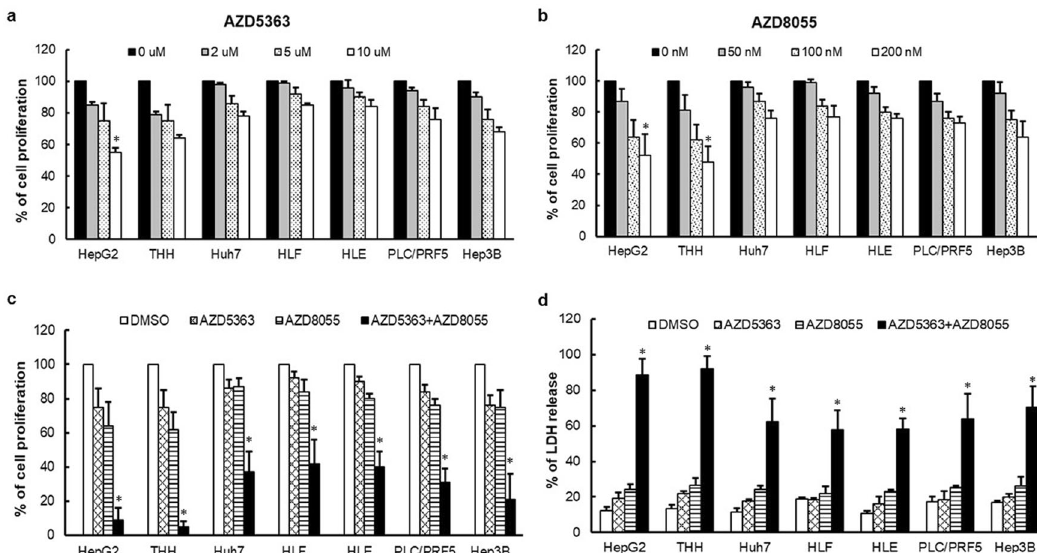
Fig. 1 Inhibition of cell proliferation by speci fi c inhibitors. Proliferation of different HCC cells were analyzed separately by MTS assay after treatment with AZD5363 ( a ) and AZD8055 ( b ), at different concentrations for 72 h. Proliferation was also analyzed by MTS assay after a combination treatment with 5 µM AZD5363 and 100 nM AZD8055 for 72 h ( c ). Cell death analyzes from LDH release after combination treatment with 5 µM AZD5363 and 100 nM AZD8055 for 72 h are also separately ( d ). The results are presented as the mean ± SD from three independent experiments. * P < 0.05 was regarded as signi fi